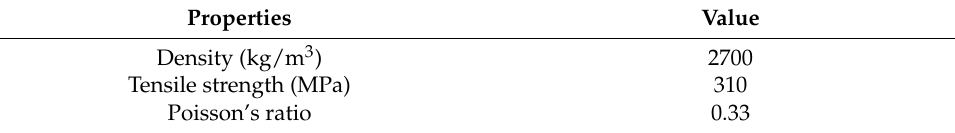
Table 2. Mechanical properties of AA6061 [33].